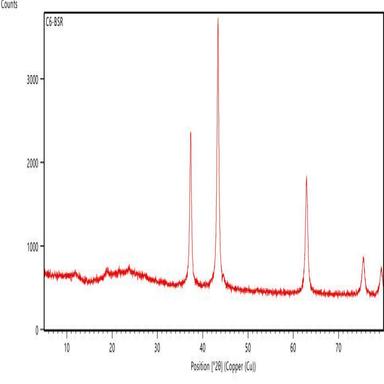
X-ray diffractogram of Ch-PANI-NiO nanocomposite.